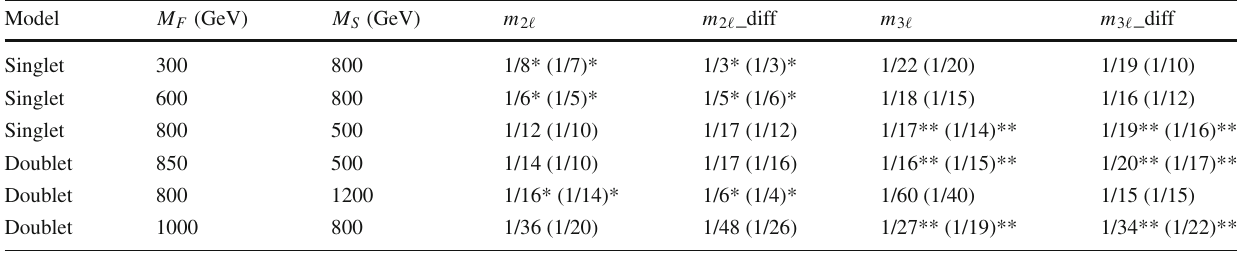
Fig. 16 Di- and trilepton invariant mass distributions m 2 (cid:5) , m 2 (cid:5) _diff, m 3 (cid:5) , and m 3 (cid:5) _diff after detector simulation for the singlet model. The observables are shown for different benchmarks of the VLLs and BSM Table 3 Scaling factors f = N peak , det / N peak for the observables of Sect. 6 for different benchmarks, with N peak , det ( N peak ) denoting the number of events at the peaks per bin after (before) detector simulation